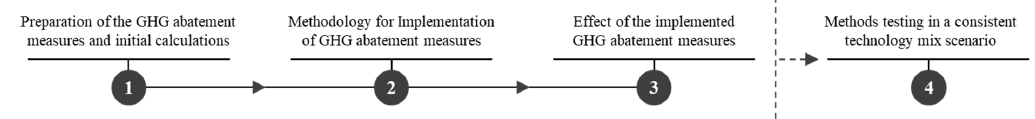
Figure 2. Inputs and outputs of SmInd and integration into the FfE model landscape.